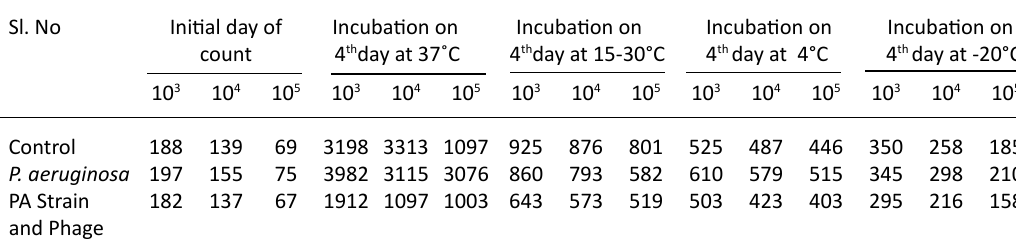
table.1.C. Showing number colony count after treated with bacteriophage against P. aeruginosa Strain on mutton samples on at completion of 4th incubation at various temperatures Sl. No